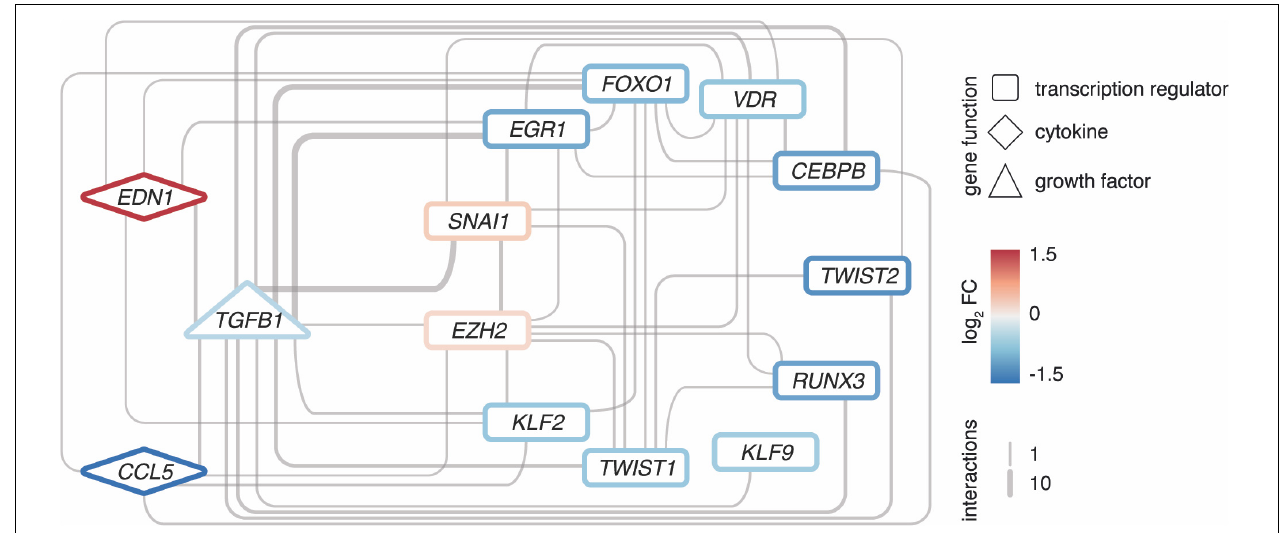
FIGURE 5 | Regulatory loops around TGFB1 link important transcription factors and cytokines. Network of EZH2 as well as upstream interactors of TGFB1 among the 2121 DEGs, respectively. Interactions based on Ingenuity Pathway Analysis and filtered for transcription regulators and cytokines. All interconnections between genes shown. Genes color-coded by mean expression change observed in MRKH / Ctrl. Line width indicates number of curated